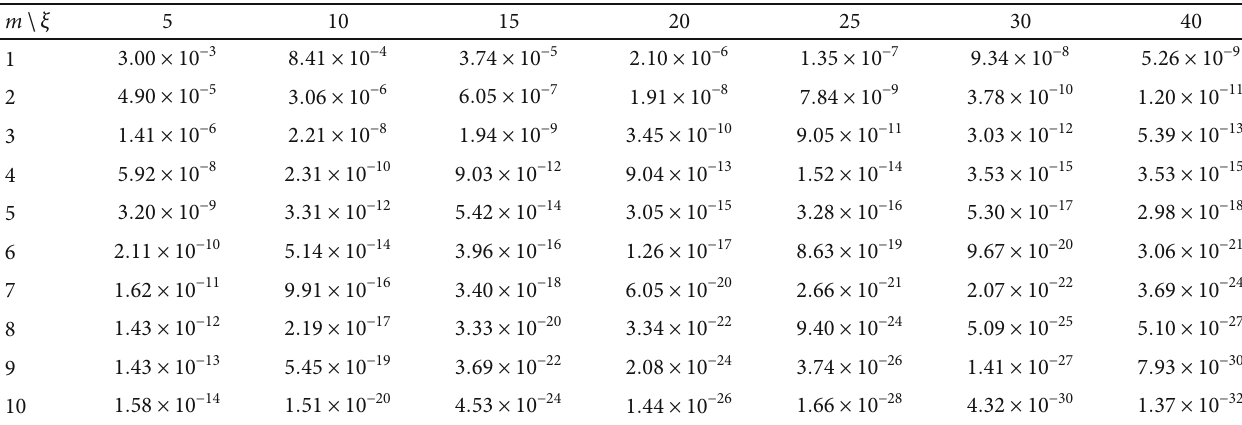
Table 4: Solution error of G ð 0, ξ Þ with increase in order of LSPM approximation when Pr = 10 , n = 0 : 5 , K = 0 : 5 , Ω = 0 : 1 , S = 3 , N He = 0 : 2